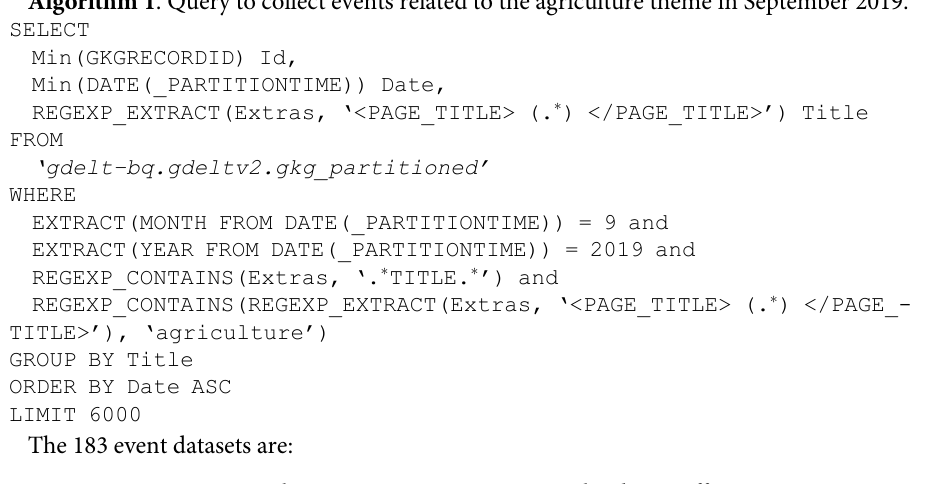
Algorithm 1 . Query to collect events related to the agriculture theme in September